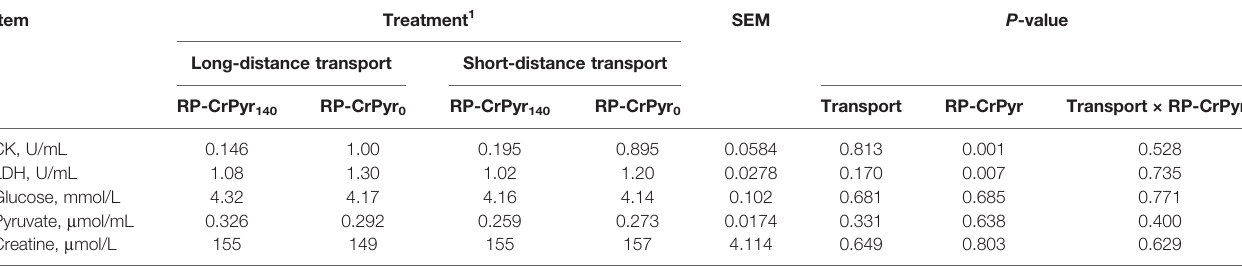
TABLE 2 | Effects of transport and rumen-protected creatine pyruvate on the serum indicators of beef cattle. Item